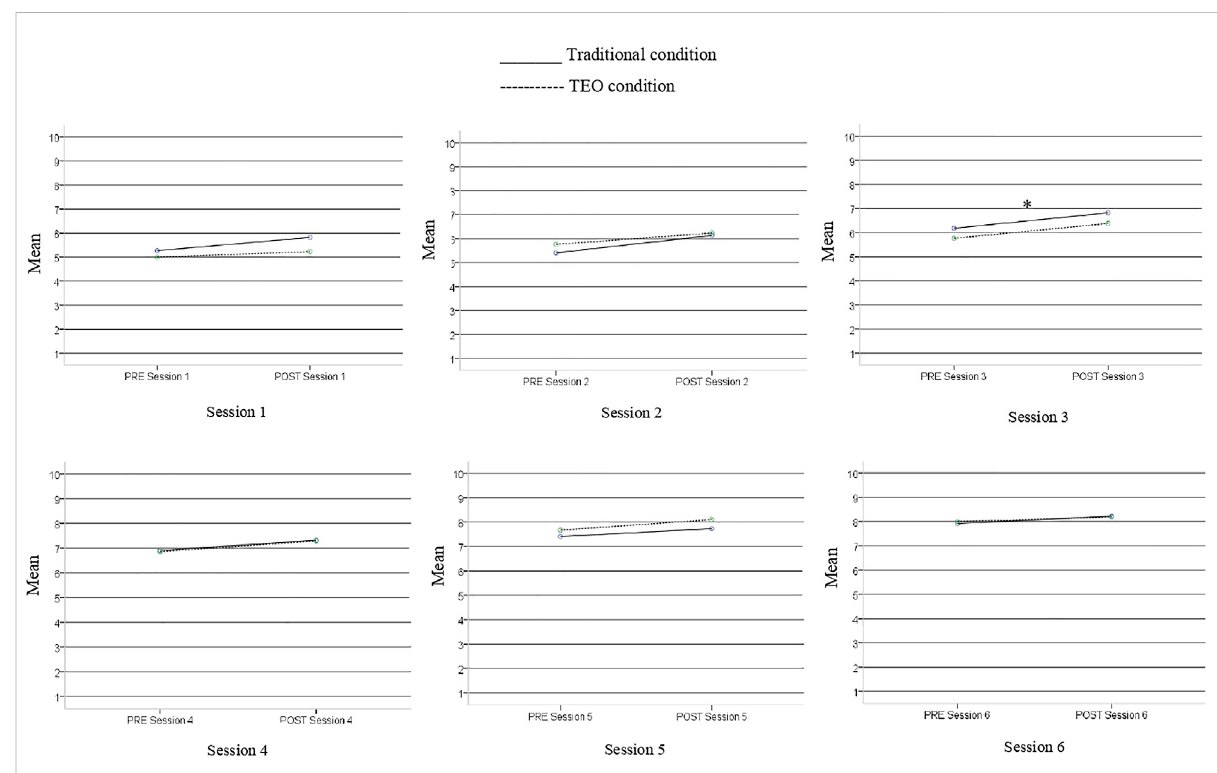
FIGURE 2 Self-ef fi cacy means for both conditions assessed before and after each homework assignment session.* Signi fi cant change compared to the fi rst session.